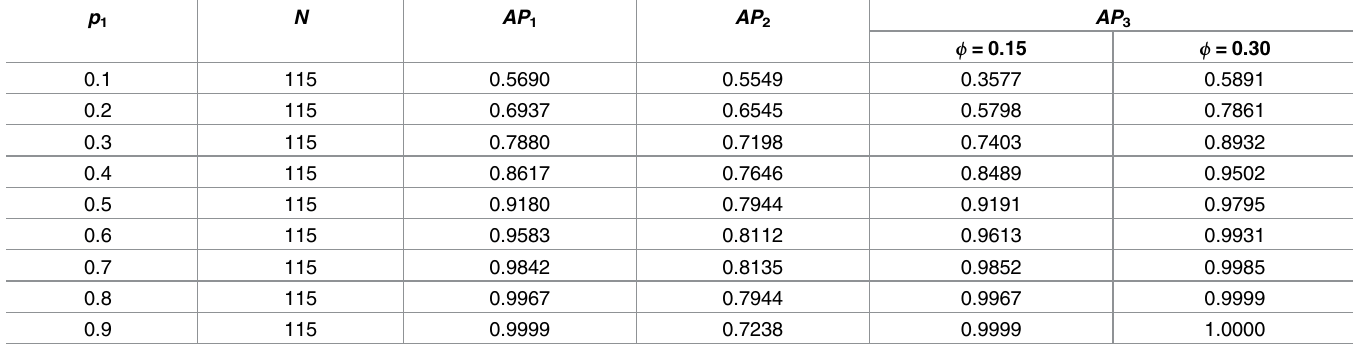
Table 2. Sample size and assurance probabilities for observing criteria (i), (ii), and (iii) given α = 0.025, β = 0.1, ( Δ 1 , Δ 2 ) = (3,0.45), ( σ 1 , σ 2 ) = (6,1), ( γ 1 , γ 2 ) = (0.5, 0.5), and ρ 12 = 0.3.